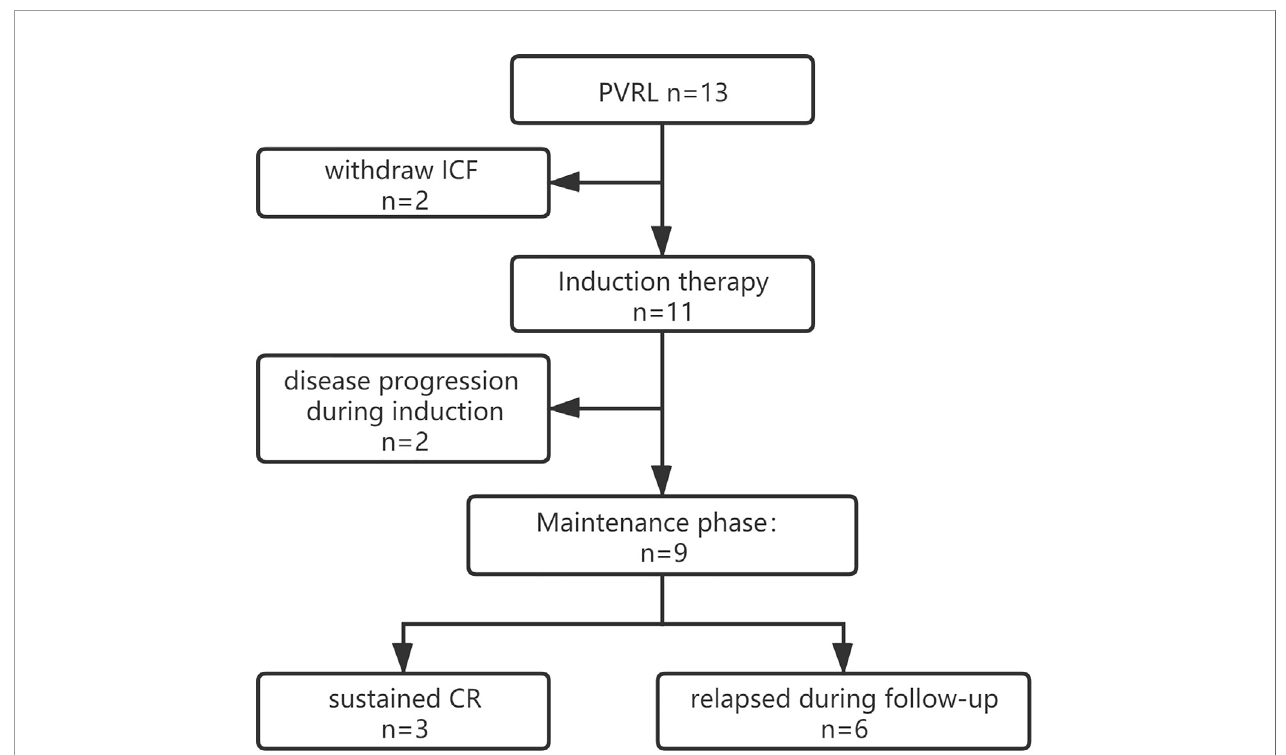
FIGURE 1 | Trial pro fi le. ICF, Informed Consent Form; CR, complete remission; PVRL, primary vitreoretinal